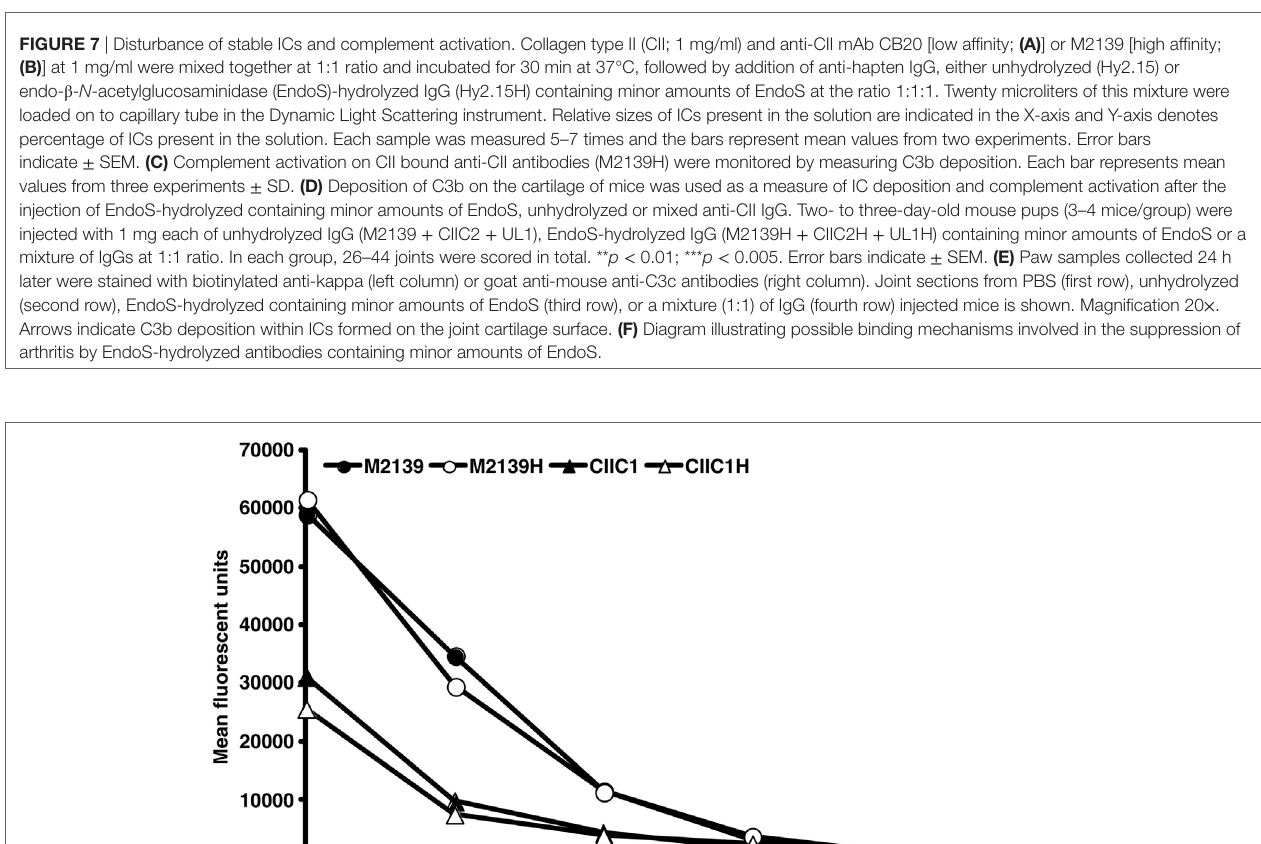
FigUre 8 | Disturbance of IC formation by rheumatoid factor (RF)-like activity of CIIC1 mAb. Endo- β - N -acetylglucosaminidase (EndoS) hydrolyzed (M2139H, CIIC1H) or unhydrolyzed (M2139, CIIC1) antibody coated (10 µg/well) ELISA plates after blocking with BSA were incubated with different concentrations of biotinylated CIIC1 antibody. Europium-conjugated streptavidin and the dissociation-enhanced lanthanide fluoroimmunoassay system were used for detection of biotinylated antibody. There was no significant difference in biotinylated CIIC1 antibody binding to EndoS hydrolyzed or unhydrolyzed M2139 and CIIC1 mAbs demonstrating negligible contribution of RF like activity of CIIC1 mAb in disturbing IC formation.